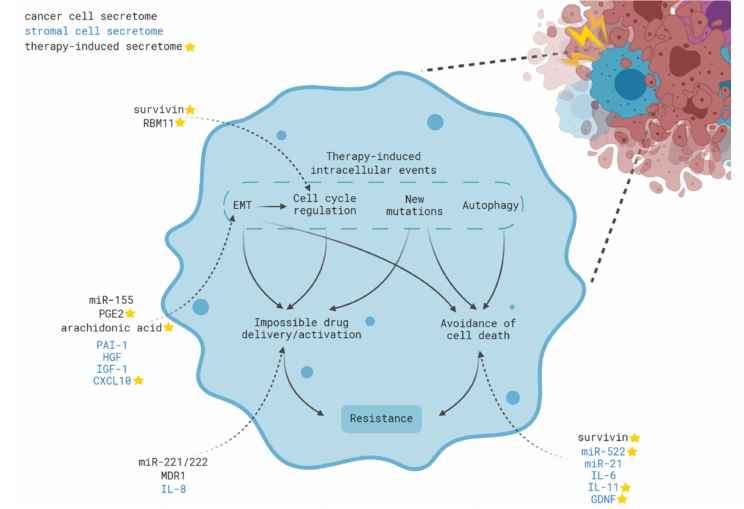
Figure 2. The role of the therapy-induced intra- and intercellular events in the acquisition of cancer cell resistance. Stress caused by anticancer therapy triggers many events (acquisition of new mutations, changes in the regulation of the cell cycle, EMT, autophagy) which then leads to avoidance of cell death and a change in the e ffi ciency of absorption / activation of the chemotherapy drug. In addition to intracellular signals, molecules from stromal cells, as well as other tumor cells, entering the cell from outside are involved in the induction of these events. Molecules of therapy-induced secretomes are marked by asterisks; molecules secreted from cancer cells are marked in black; molecules secreted from stromal cells are marked in